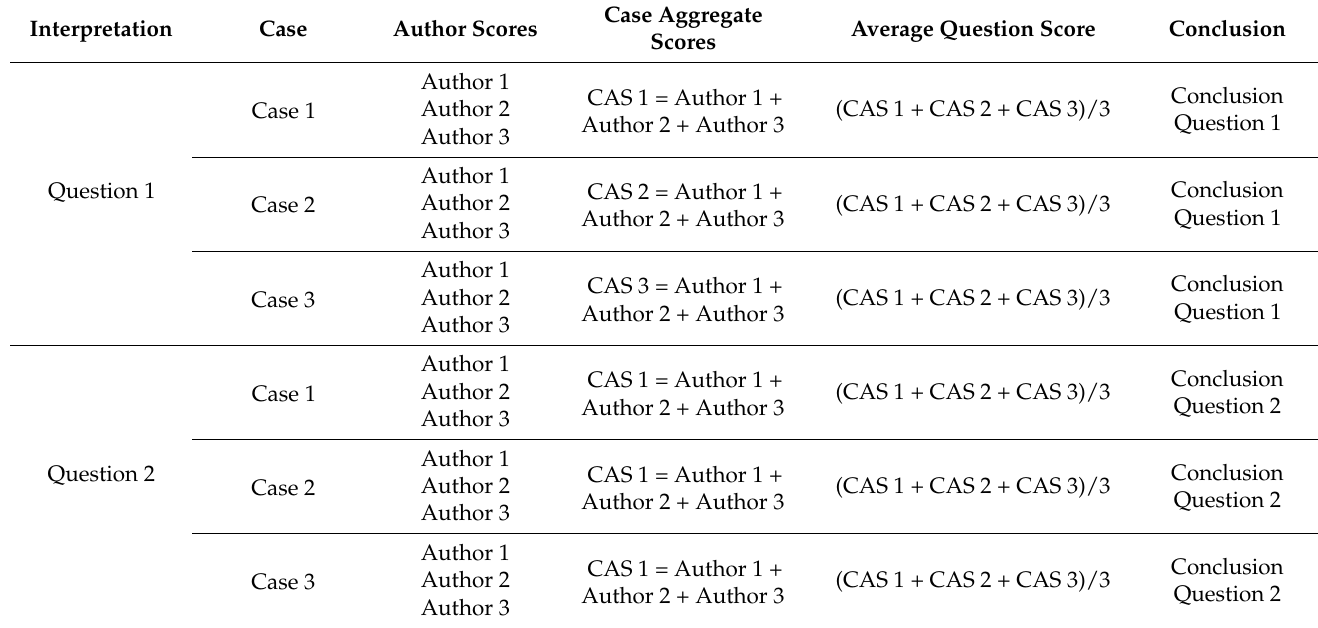
Table A3. Illustration of Scoring Progression for Questions 1 and 2.